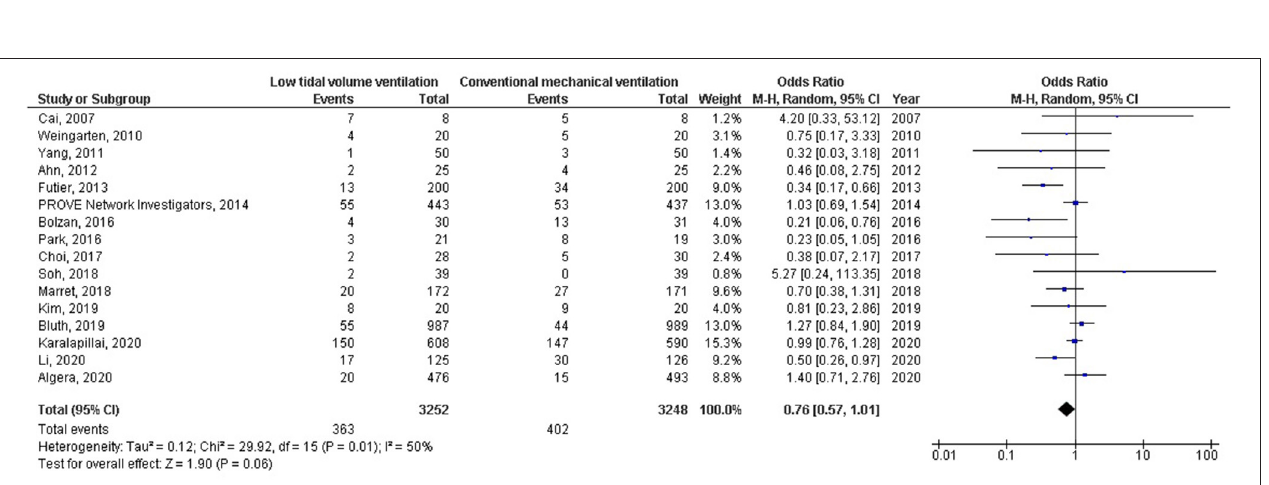
FIGURE 5 | Forest plot of the low tidal volumes strategy vs. conventional mechanical ventilation in subjects undergoing surgery on atelectasis.